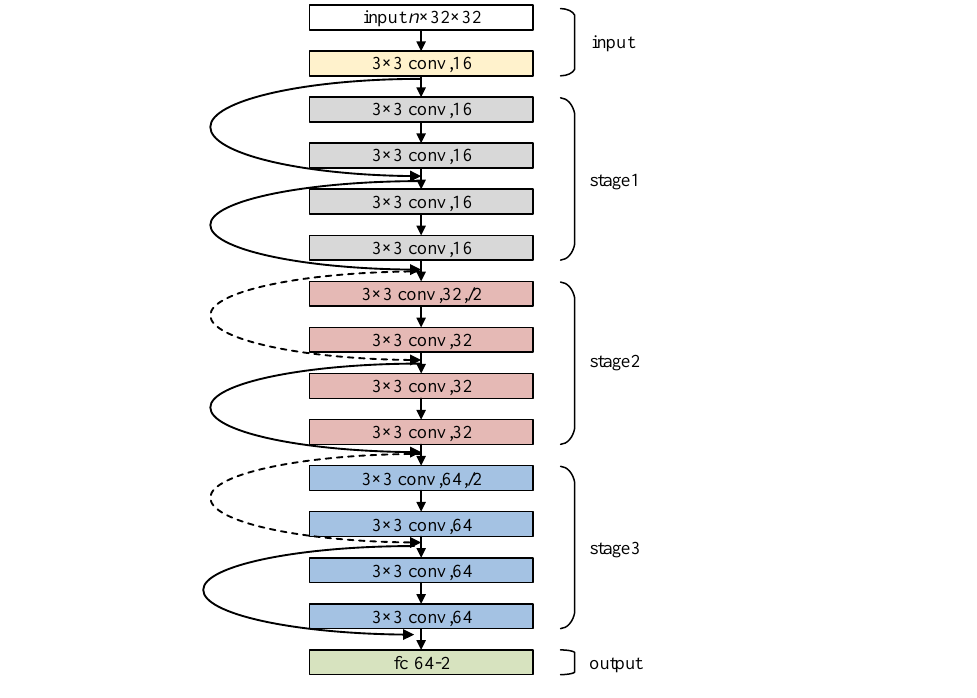
Figure 4. The architecture of the proposed DCNN.